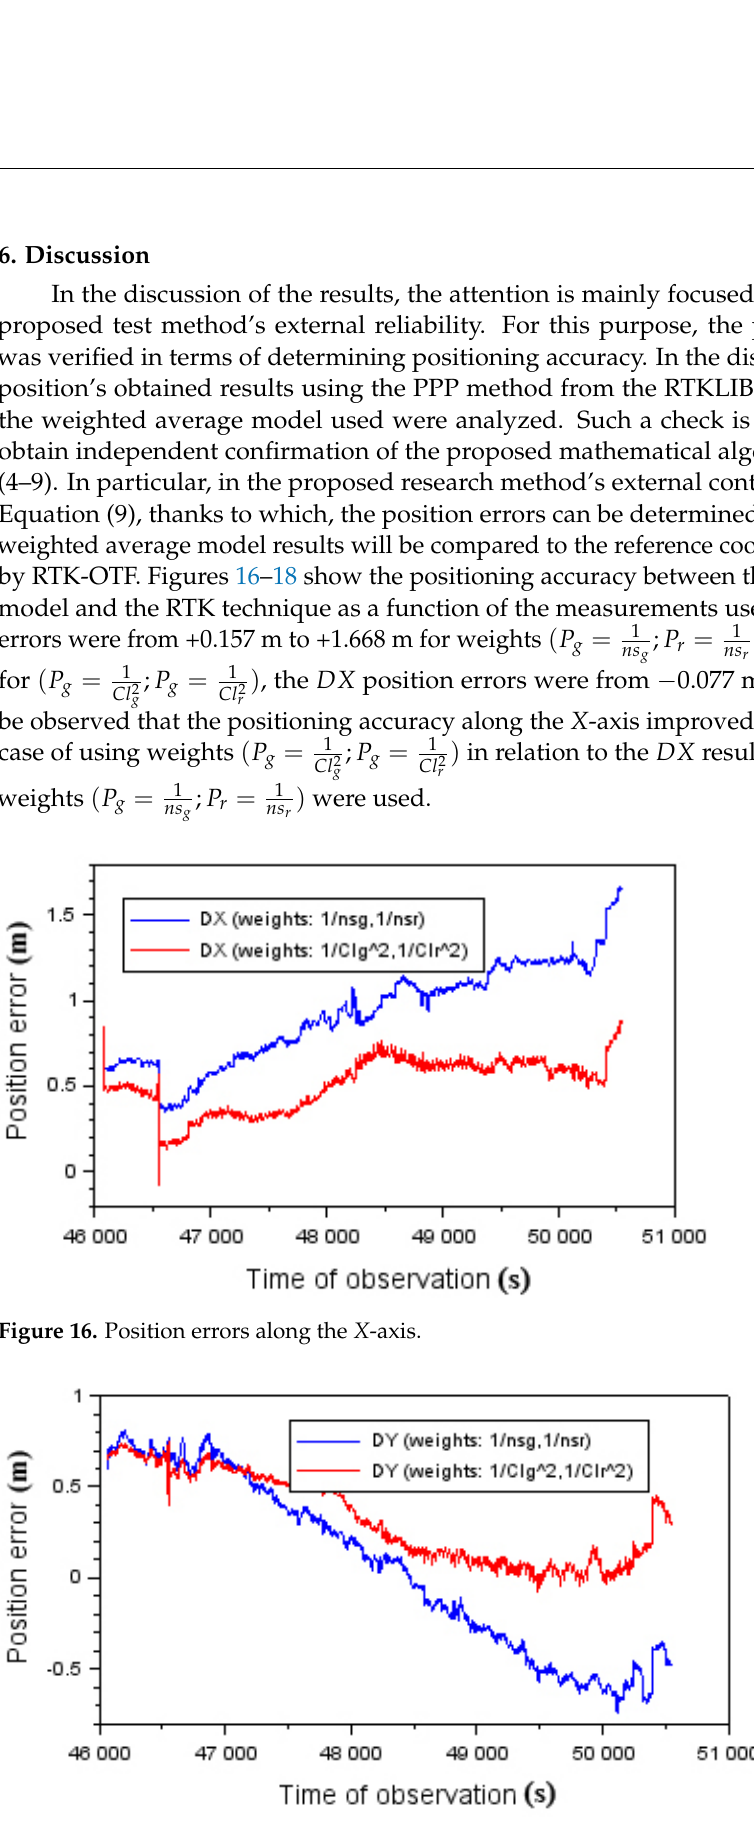
Figure 18. Position errors along the Z -axis .